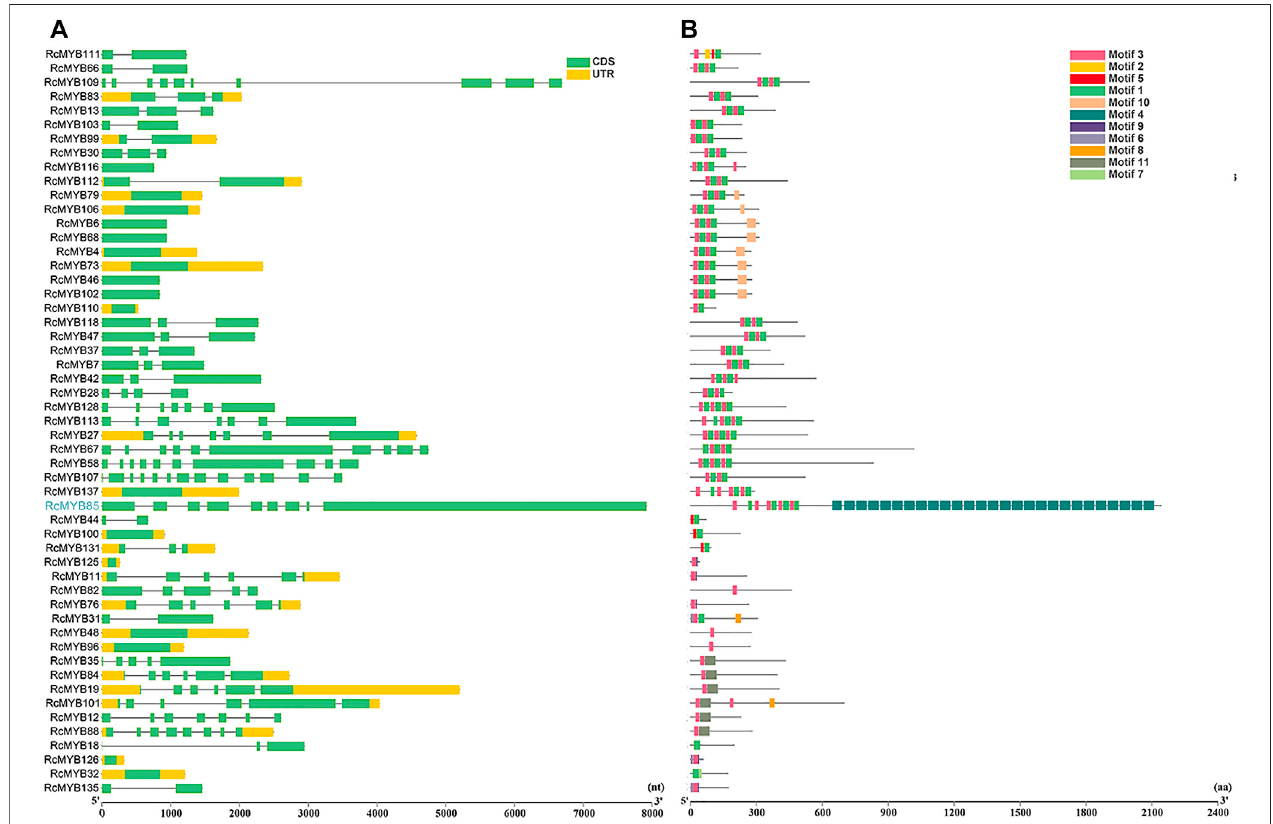
FIGURE 3 | The gene structures and conserved motifs of RcMYB genes (1R-, 3R-, and 4R-) (A) The coding sequence (CDS) and untranslated region (UTR) were displayed in different colors, and the lines between boxes represented introns. (B) The phylogenetic tree constructed with RcMYB proteins and conserved domains of the RcMYB family was analyzed by MEME suite. Different colors indicated different